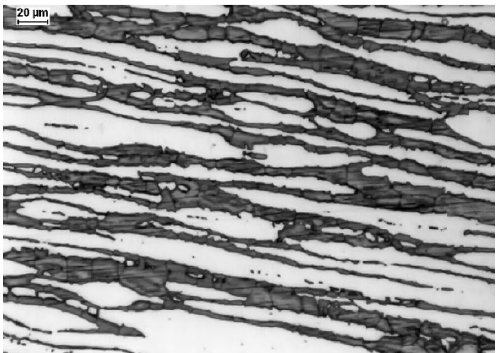
Figure 2. A properly balanced duplex steel microstructure containing approximately 50% of each δ -ferrite (dark areas) and γ -austenite (light areas)—according to [21].